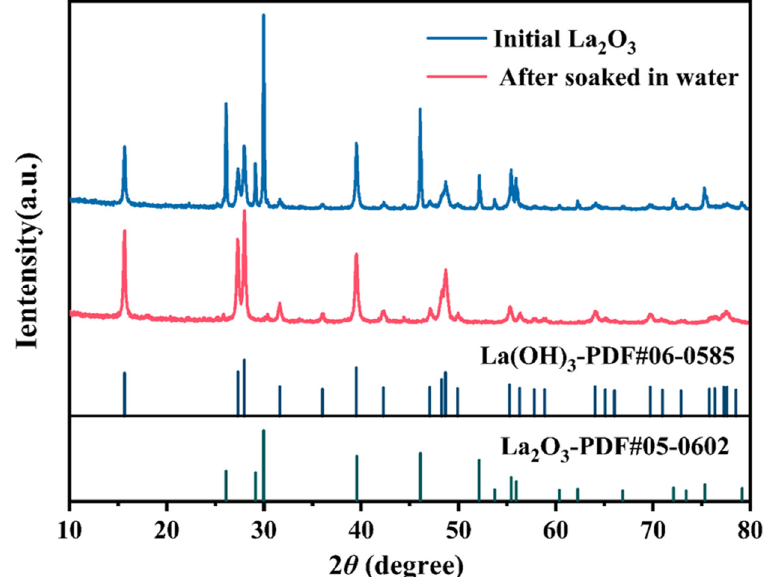
Figure 6. XRD pattern of initial La 2 O 3 and La 2 O 3 soaked in